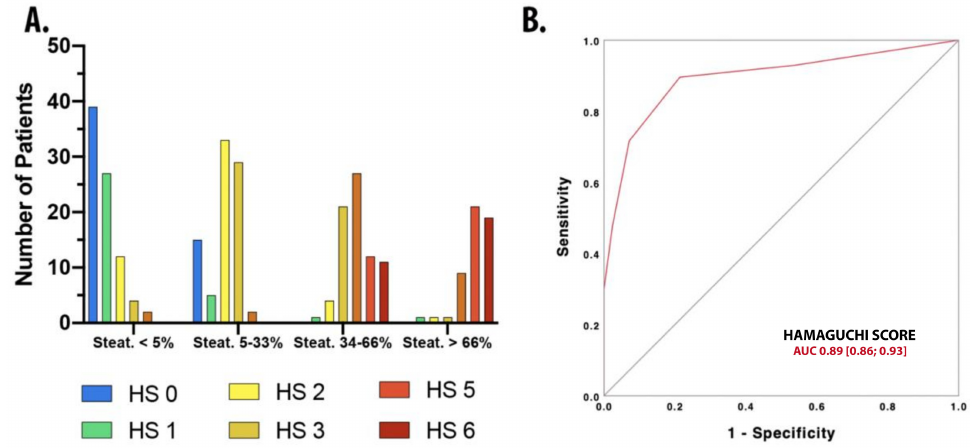
Figure 3. ( A ) Distribution of HS between Kleiner steatosis scores. ( B ) ROC employed to describe HS discriminative ability of HS for steatosis > 5% as proven by liver histology. HS = Hamaguchi